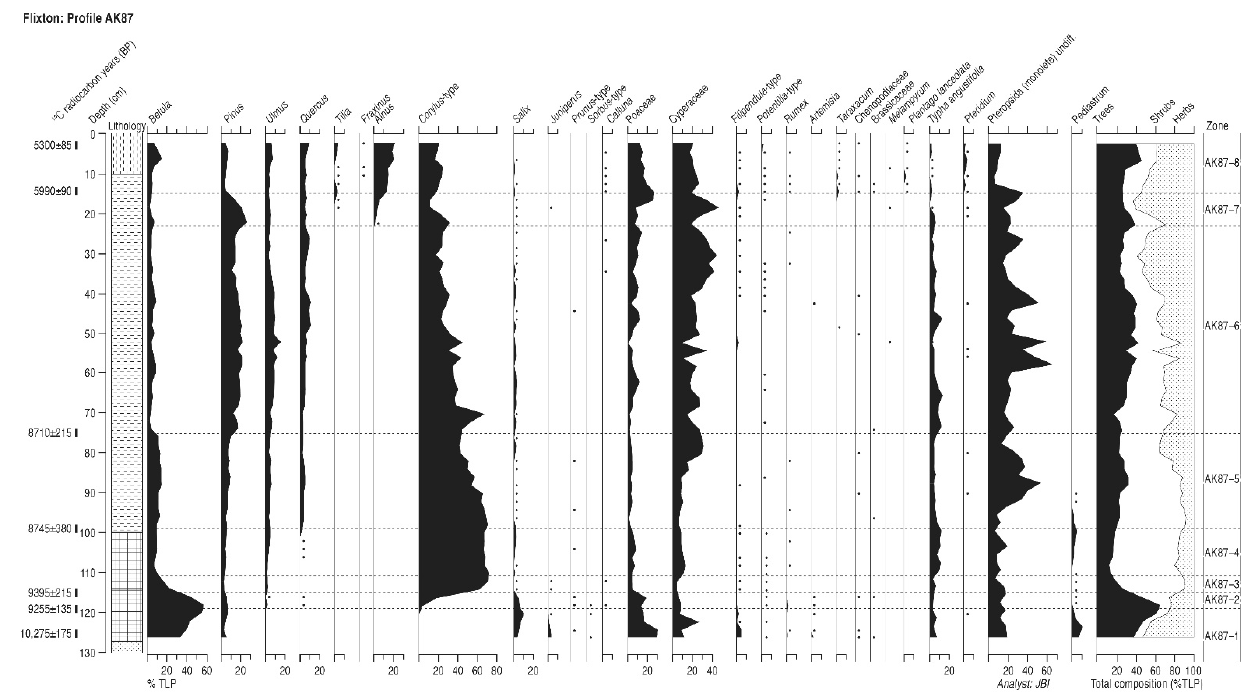
Figure 6. Percentage pollen diagram from Flixton profile AK87. (Analysis JBI).